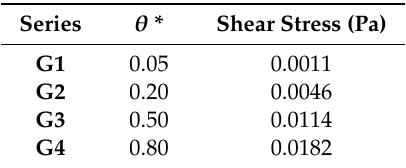
Figure 2. Identifying critical shear stress ( τ cr ) of the sediment by measuring resuspended particles in response to stepwise increases of the motor speed of the experiment setup. τ = τ cr was recognized when the motor speed reached 15 r / min. Table 1. Hydrodynamic conditions chosen for the experiments.